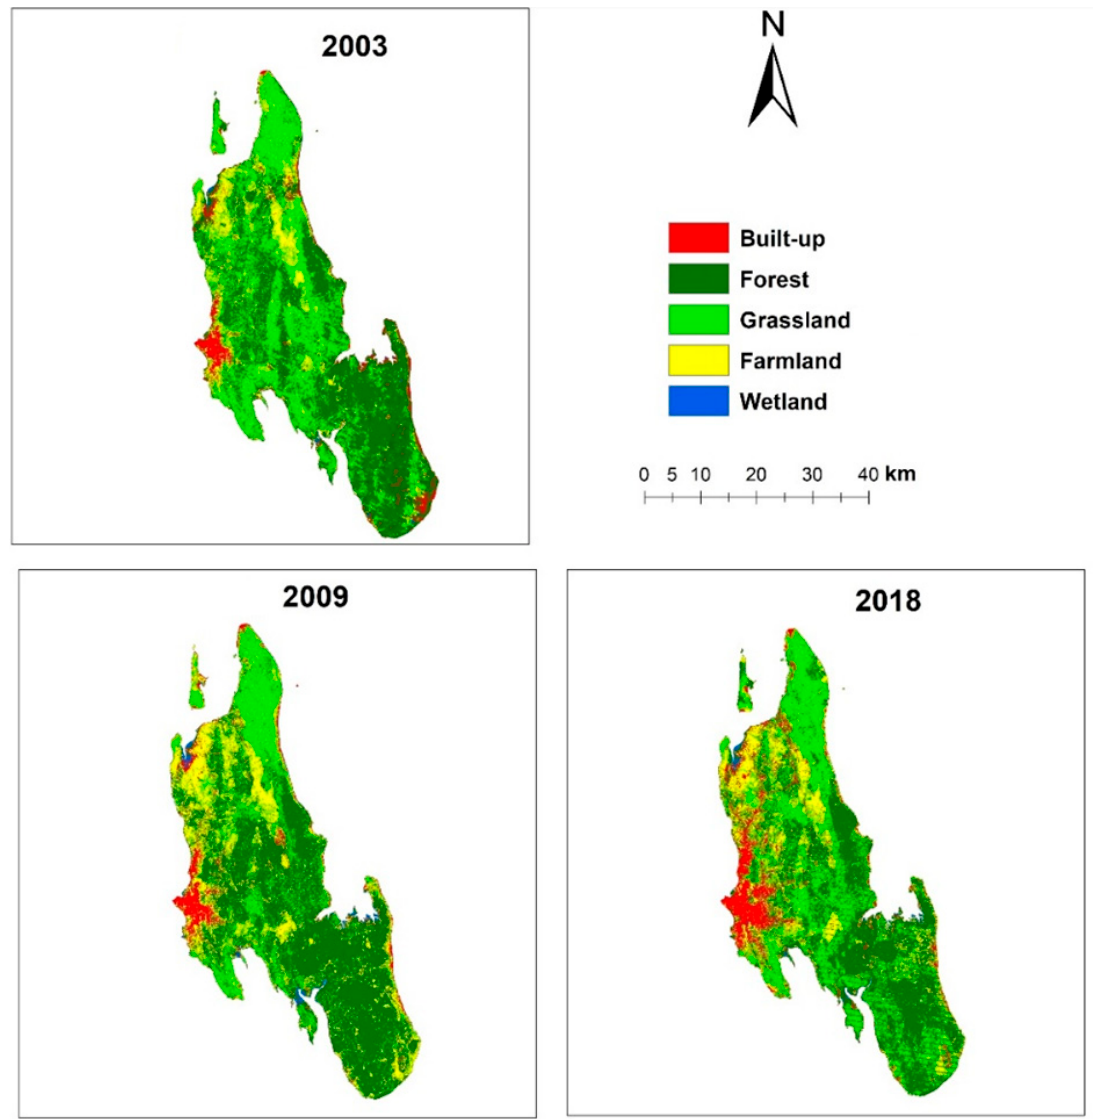
Figure 6. Land Use Land Cover maps for the years 2003, 2009, and 2018.